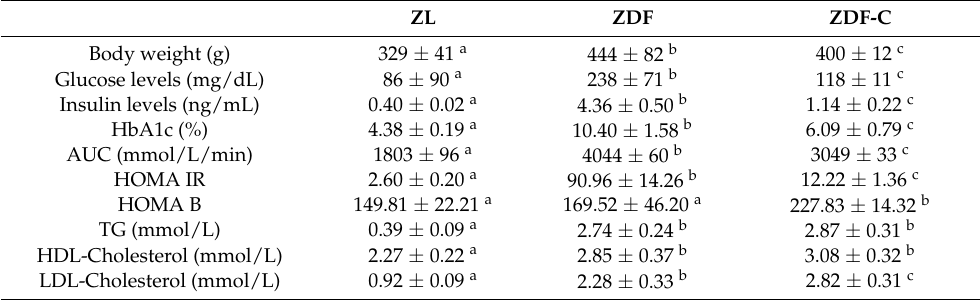
Table 1. Biological parameters of Zucker lean rats (ZL), Zucker diabetic fatty rats fed with control diet for 10 weeks (ZDF), and Zucker diabetic fatty rats fed with cocoa diet for 10 weeks (ZDF-C). Data represent the means ± SD of 6–8 animals. Different letters denote statistically significant differences, p <